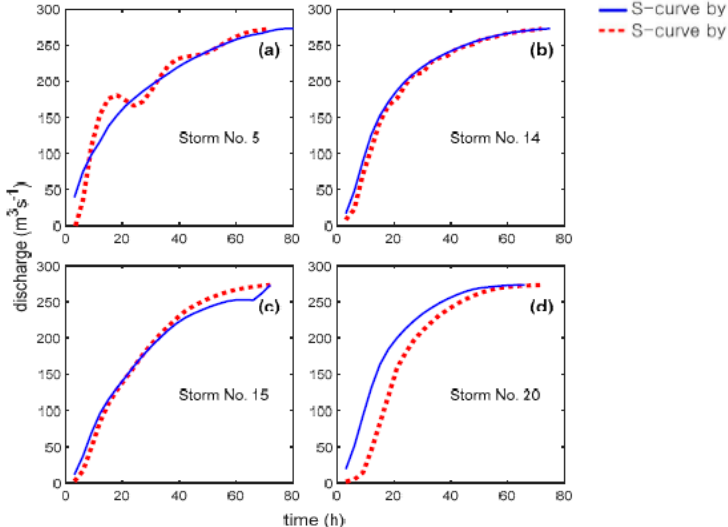
Figure 2. Comparison between S-curves for each storm derived by the SRS method and those based on UH obtained by the least square method using rainfall data: ( a ) for Storm No, 5; ( b ) for Storm No. 14; ( c ) for Storm No, 15; ( d ) for Storm No. 20.